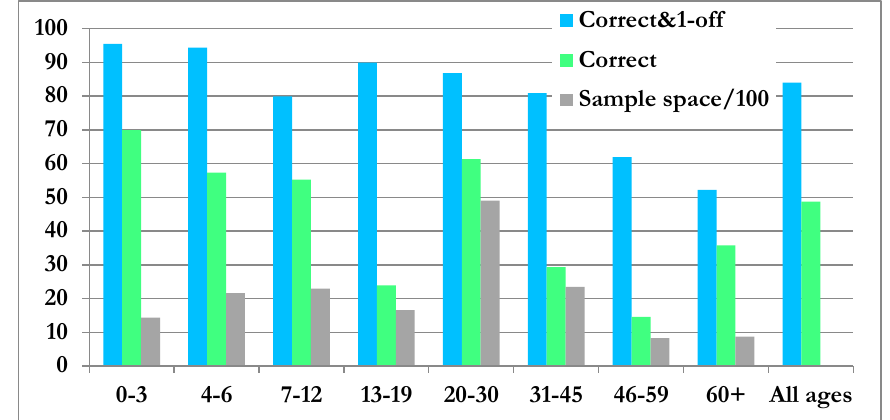
Fig. 13. Accuracy of the age estimation algorithm.